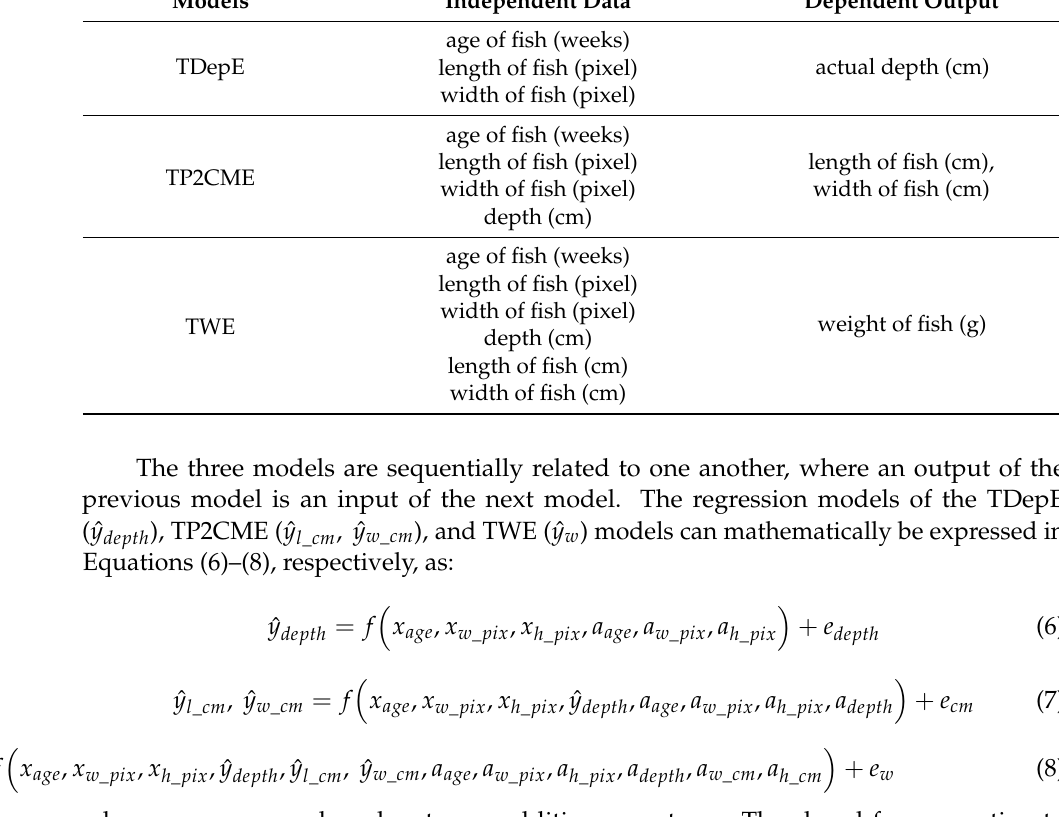
Table 1. Independent data and dependent output of TDepE, TP2CME, and TWE models.